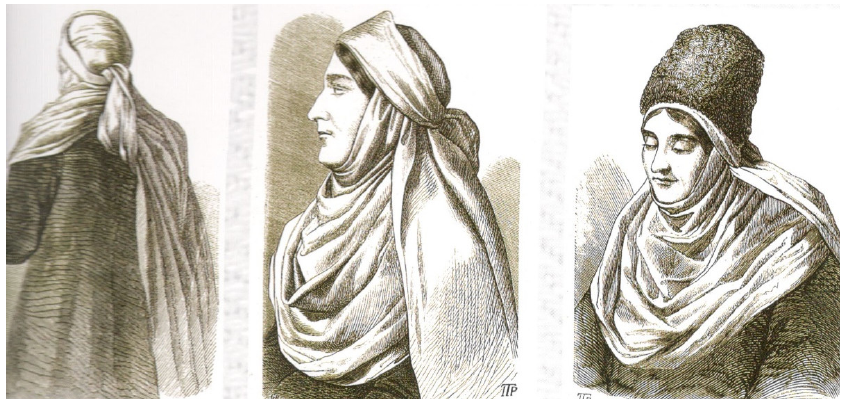
Figure 7. Married female headdresses [58].